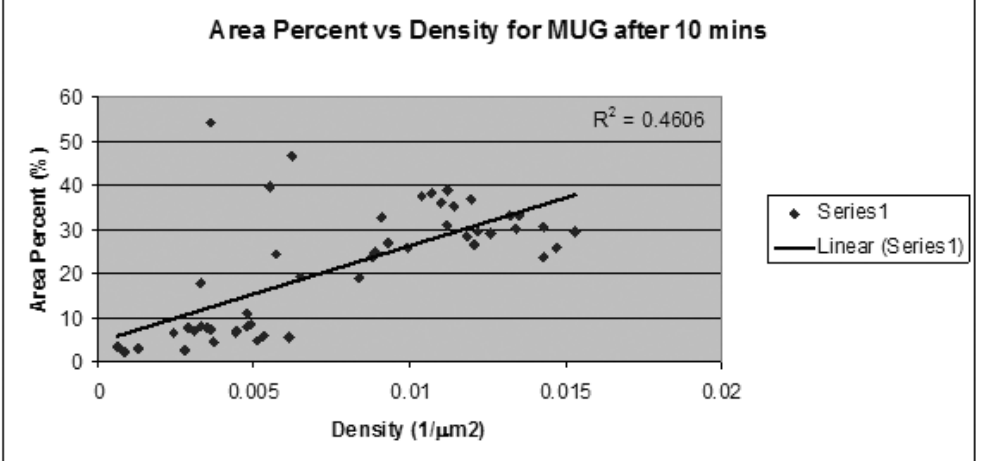
Figure 12: Area Percent vs. Density of wear for MUG after 10 minutes.